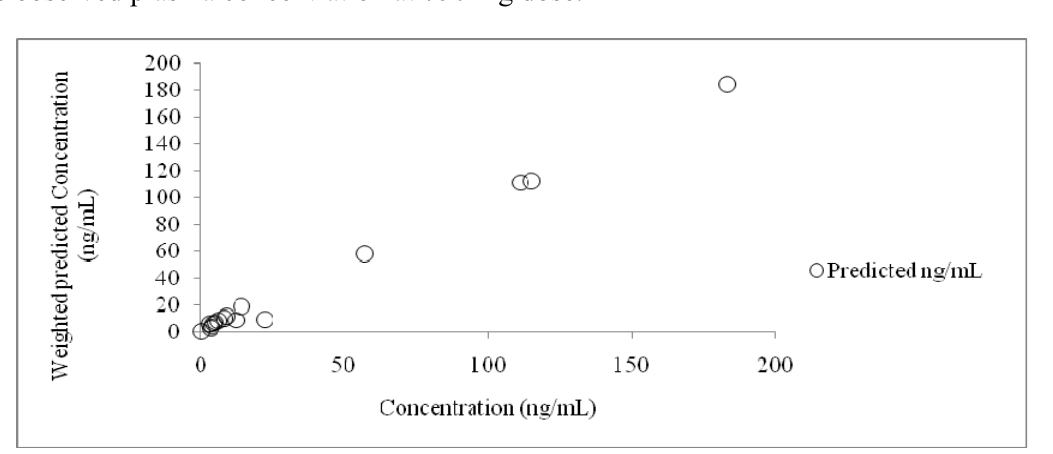
Figure 5. Scatter plot showing relation of weighted predicted plasma concentration versus the observed plasma concentration at 750 mg dose.